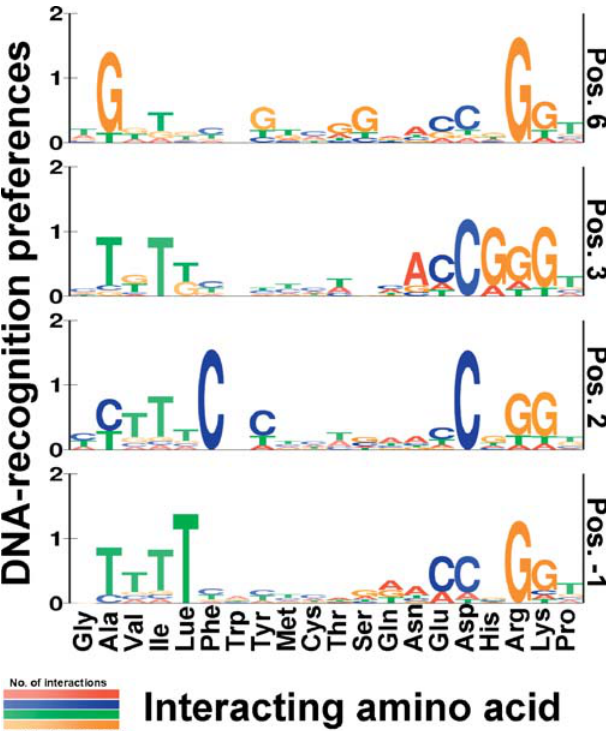
Figure 4. Four Sets of Position-Specific DNA-Recognition Preferences in Zinc Fingers The estimated sets of DNA-recognition preferences for the DNA-binding residuesatpositions6,3,2,and (cid:1) 1oftheZincFingerdomainaredisplayed as sequence logos. At each position, the associated distribution of nucleo- tidesisdisplayedforeachaminoacid.Thetotalheightoflettersrepresents the information content (in bits) of the position, and the relative height of each letter represents its probability. Color intensity indicates the level of confidence for a given amino acid at a certain position (where paler colors indicate lower confidence due to low occurrences of the amino acid at the specific position in the training data) (see Tables S1 and S2 for full data). Some of the DNA binding preferences are general, regardless of the residue’s position within the zinc finger (e.g., lysine’s tendency to bind guanine), while others are position-dependent (e.g., the tendency of phenylalanine to bind cytosine only when in position 2). DOI: